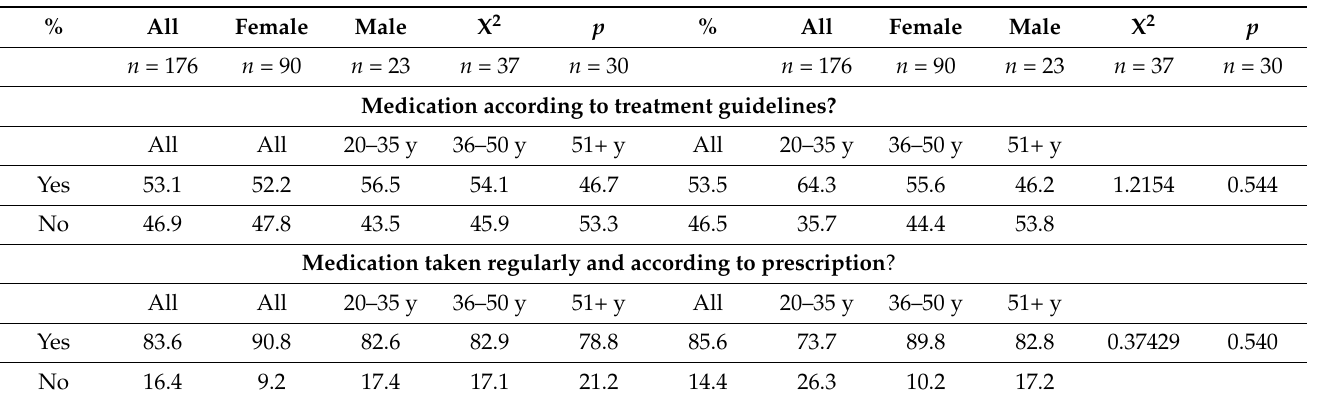
Table 4. Frequency of guideline-compliant drug